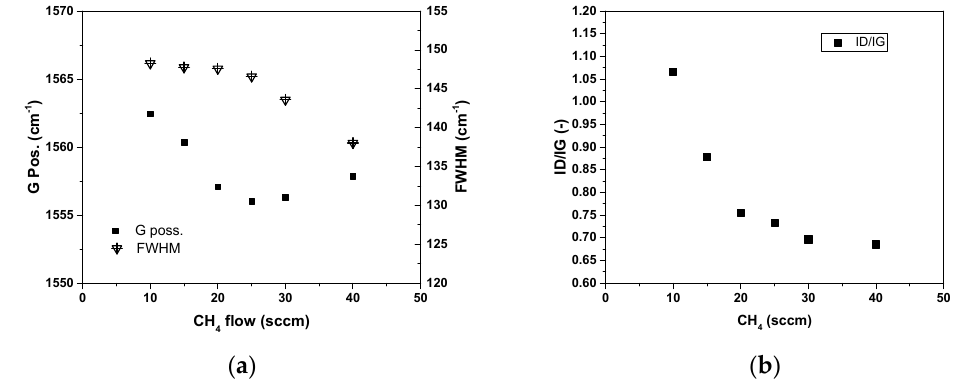
Figure 3. Raman analysis of the coatings deposited with different CH 4 flows: ( a ) G position and FWHM (G) and ( b ) ID/IG .